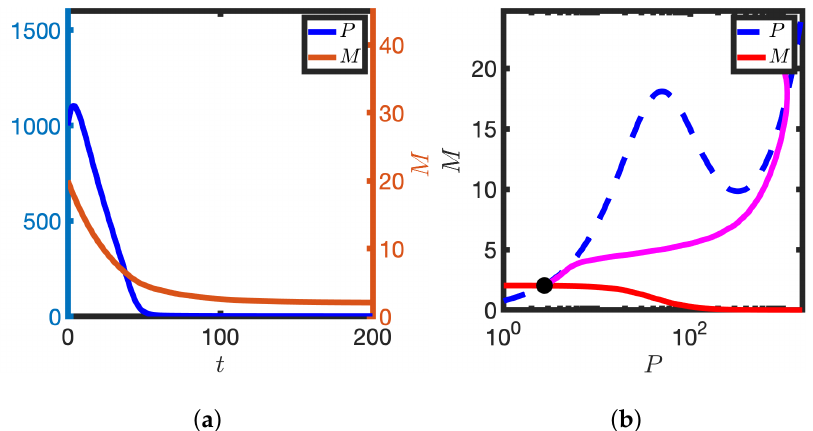
Figure 2. Homeostasis in the case of low transcription rate. ( a ) P and M are plotted against time, t . ( b ) The corresponding solution (magenta line) is plotted in the PM phase plane. P nullcline (dashed blue line), M nullcline (solid red line), Steady state (black dot). Equations (2) were solved numerically. k 1 = 0.234. Other parameter values in Table